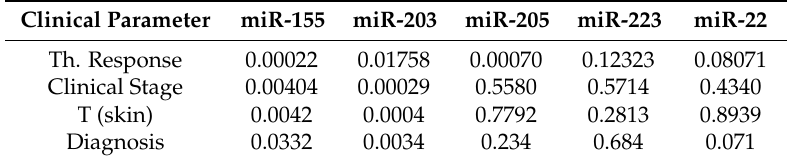
Table 2. Effect of miR-levels on probability of the CTCL progression.